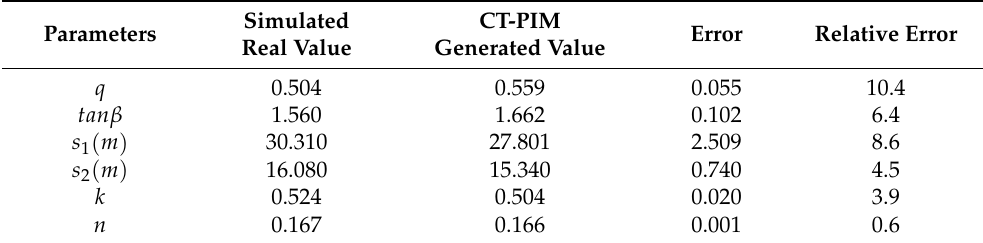
Table 1. Estimated CT-PIM parameters (under the 10 interferometric